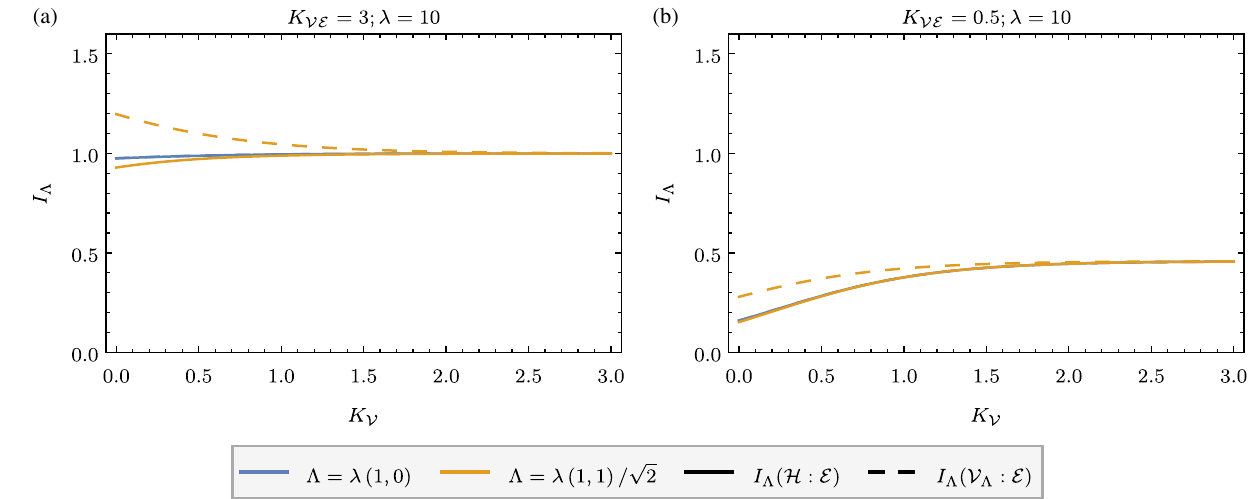
FIG. 13. The mutual information I Λ ð H ∶ E Þ and I ð V Λ ∶ E Þ for decimation (blue) and majority-rule (yellow) procedures in the 1D periodic toy model Eq. (E1) obtained by coupling the environment spins e 1 ; 2 in the model Eq. (25) with a coupling K E ¼ 1 . 5 (the value shown). Compare with Fig. 6, for which all other parameters are the same. Similarly, two parameter regimes are shown: (a) strong coupling to the environment or low-temperature K VE (recall that the coupling constants contain a factor of β ¼ 1 =k B T ) and (b) weak coupling K VE . The solid lines differ from the dashed lines of the same color by the mismatch I ð V Λ ∶ E j H Þ (see the main text). Note that the introduction of K E coupling rendering the environment simply connected also in this 1D case greatly reduces the difference between the two RG